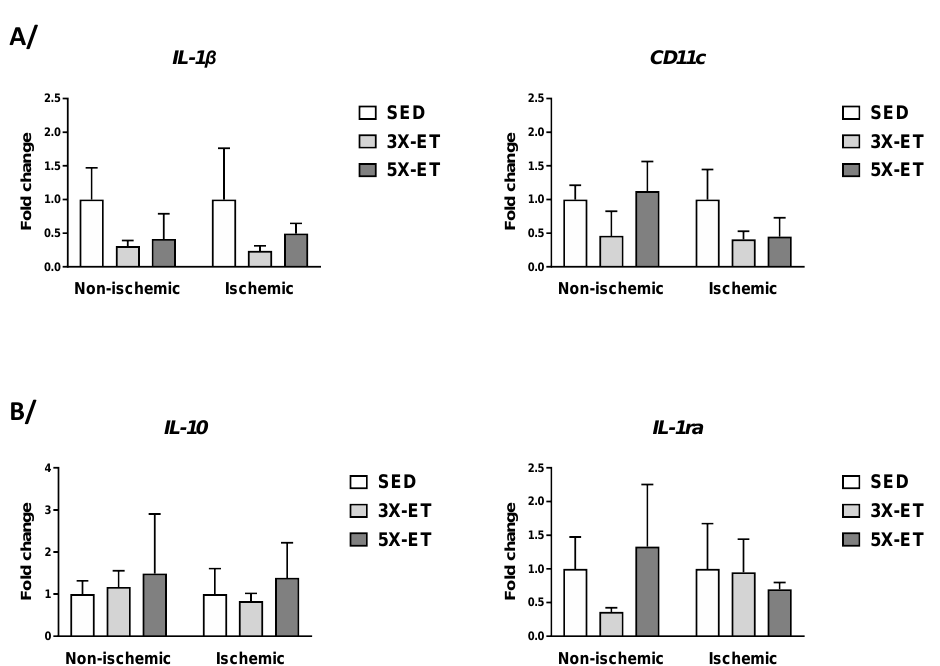
Figure 7. Expression of genes related to pro-inflammatory markers ( IL-1 β and CD11c ) ( A ) and anti- inflammatory cytokines ( IL-10 and IL-1ra ) ( B ) in non-ischemic and ischemic muscles of sedentary (SED), three times (3X-ET), and five times (5X-ET) a week exercised ApoE −/− mice with PAD. Data were normalized to 36B4 gene and expressed as fold-change over respective SED group. Results presented as the mean ± SEM ( n = 4–5 mice per group). Data were analyzed using one-way ANOVA with Holm–Sidak’s post hoc tests.